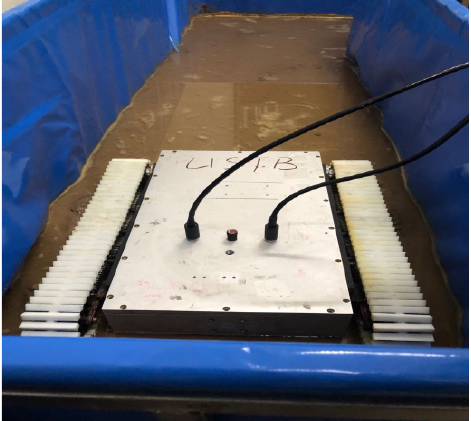
Figure 12. Tracked vehicle travel test on soft soil.